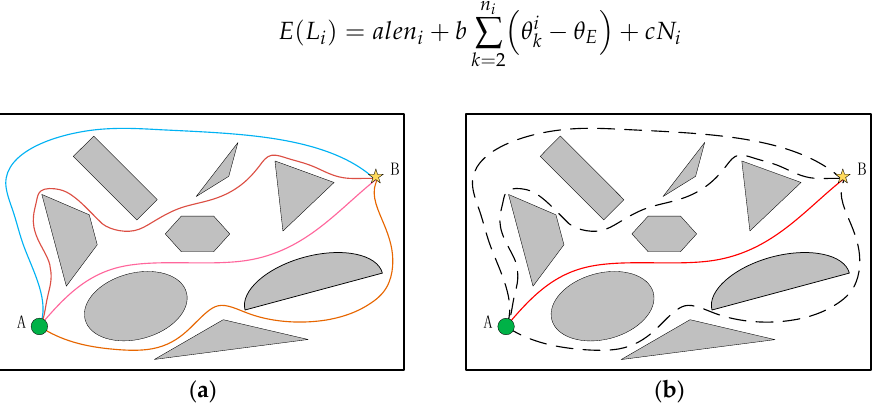
Figure 4. Illustration of the evaluation function. In ( a ), run the dual RRT optimization multiple times to get multiple desired paths; in ( b ), use the evaluation function to get a better path as the final result of the algorithm.